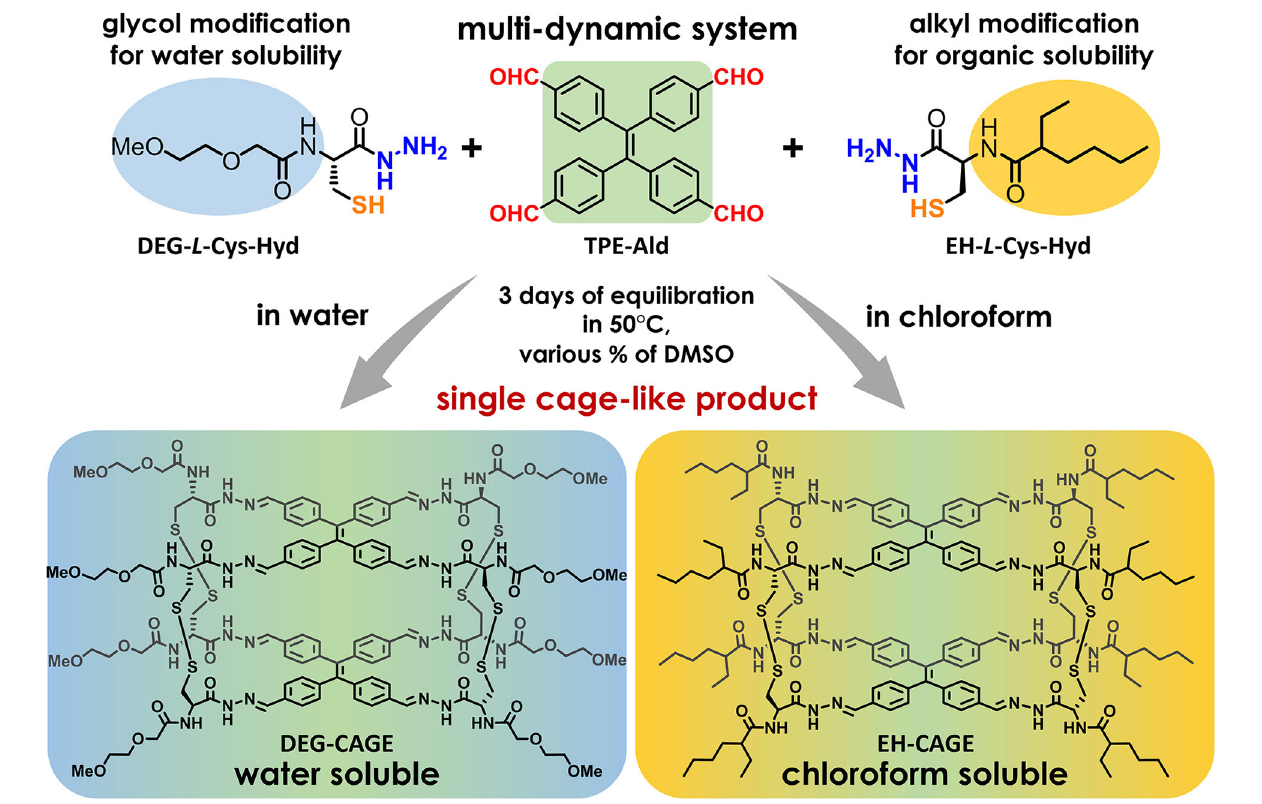
FIGURE 1 | General scheme of the molecular cages formation process. Three functional groups involved in the self-assembly process were marked with colored atom labels (aldehyde: red; hydrazide: blue; thiol: orange). Structural modifications that change the physical properties of the cage have been shown in background color (light-blue for diethyl glycol moiety and light-yellow for ethyl-hexyl moiety). The color-gradient under the structure of each cage shows the contribution of individual fragments in the solubility property of the entire